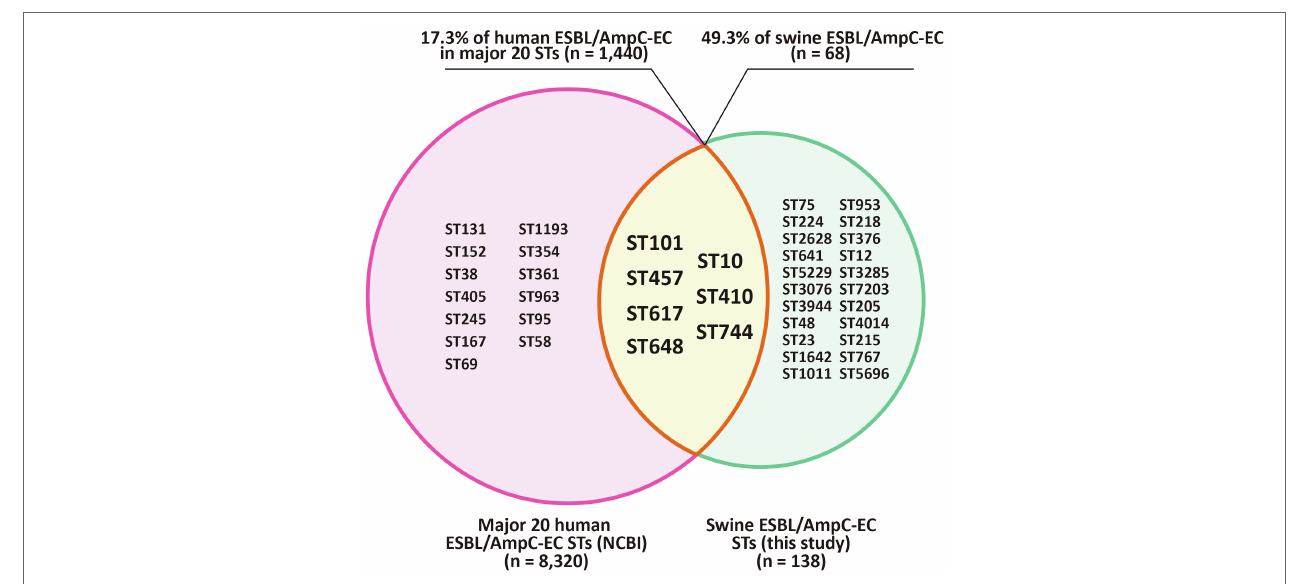
FIGURE 7 | Shared major STs of ESBL/AmpC-EC isolated from swine farms and humans. Venn diagram shows the STs shared between swine farm derived ESBL/ AmpC-ECs from this study and ESBL/AmpC-ECs from human sources which registered in the NCBI Pathogen Isolation Database. The intersection area of the two circles represents to the seven shared STs (ST101, ST10, ST457, ST410, ST617, ST744, and ST648) of ESBL/AmpC-EC from swine farms and human sources. ST, sequence